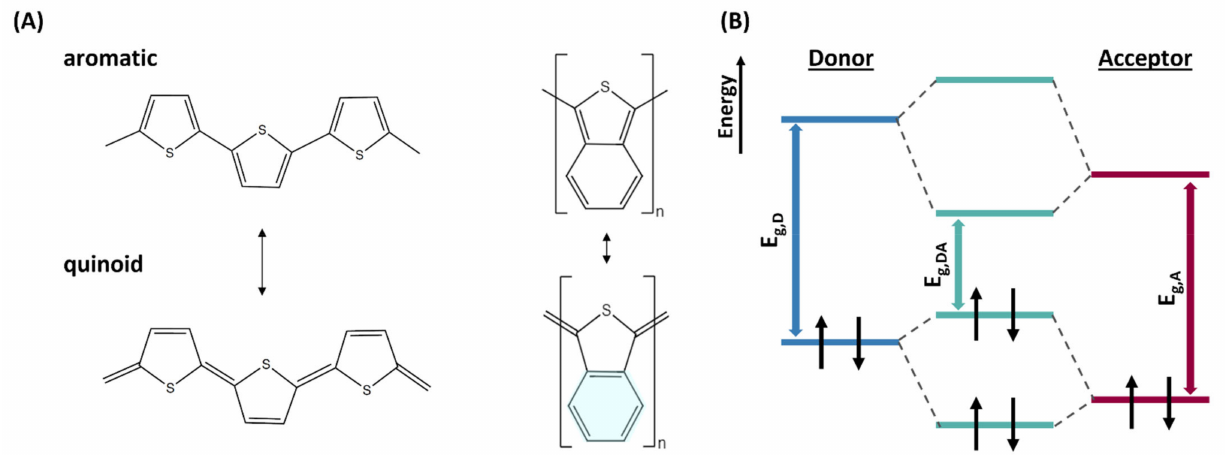
Figure 1. ( A ) Examples of aromatic and quinoid forms of polythiophene and polyisothiophene (left) and poly(isothianaphthene), stabilized by the benzene ring resonance energy upon formation of the quinoidal form. ( B ) Energy diagram of donor and acceptor moieties and hybrid orbitals of D-A type